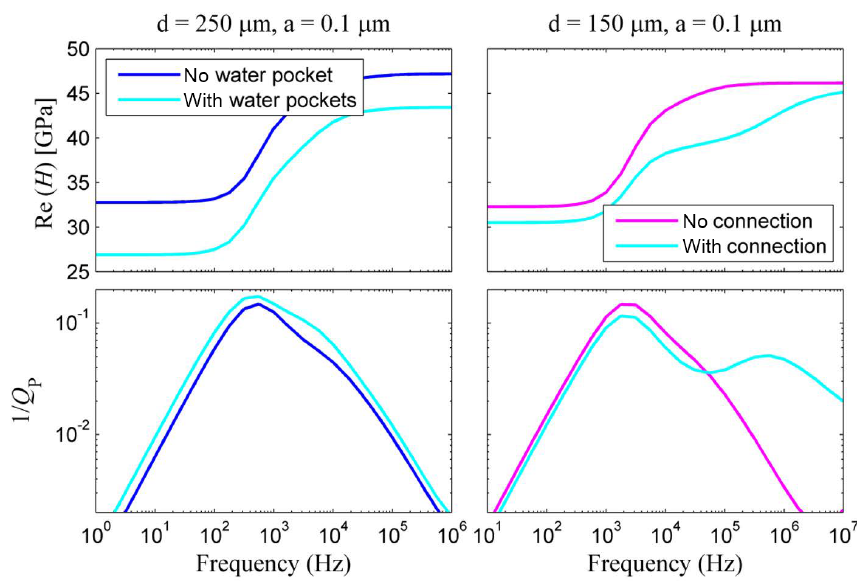
Figure 14. Real part of P wave modulus, H , and corresponding P wave attenuation, 1 /Q P , as functions of frequency, for the models shown in Fig. 13 in comparison with the corresponding results from the model shown in Fig. 7 and given in Fig. 9. The grain diameter ( d ) and thickness ( a ) of the interfacial water film are indicated in the plot titles.